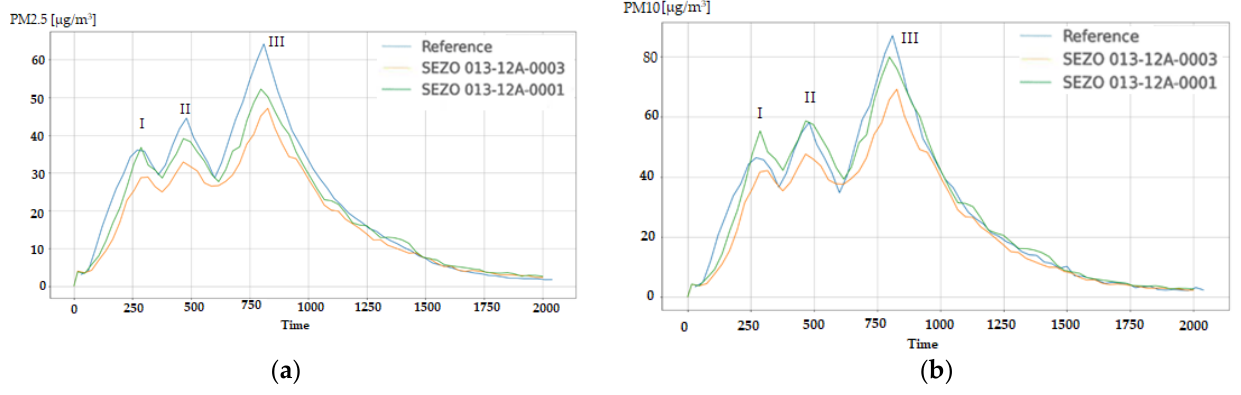
Figure 11. Variability of the concentration of PM2.5 ( a ) and PM10 ( b ) as a function of time (s) obtained using the SEZO AM method and the reference TSI OPS3330 method during tests in a dust chamber.